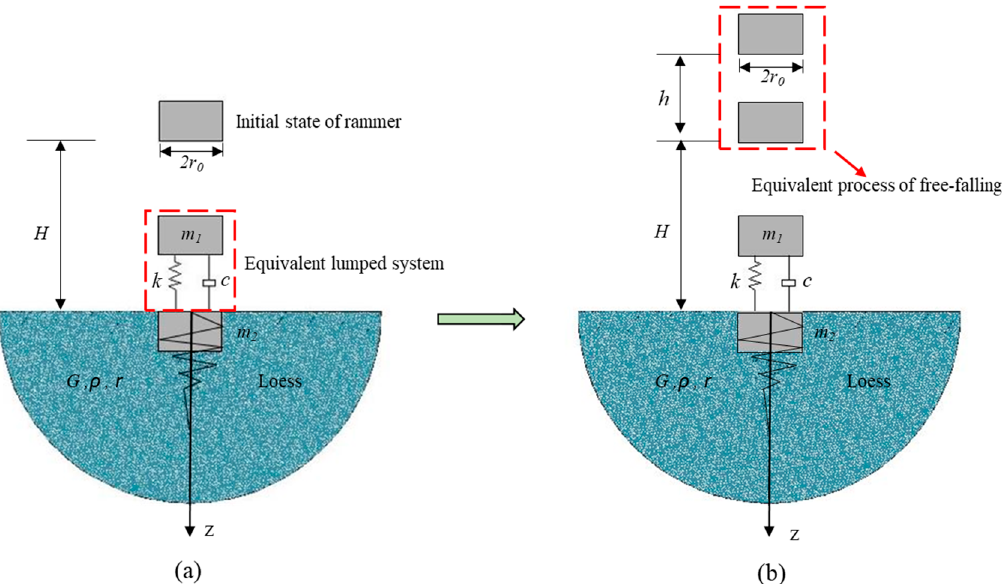
Figure 1. Mechanical model of rammer and soil: ( a ) dynamic compaction model; ( b ) hydraulic tamping model. For both images m 1 : rammer mass; m 2 : impacted soil mass; r 0 : equivalent radius of rammer; H: falling height of rammer; h: equivalent free-falling height; k: soil stiffness; c: soil damping; G: shear modulus of soil ; ρ : density of soil; r : radius of reinforced area of subgrade.